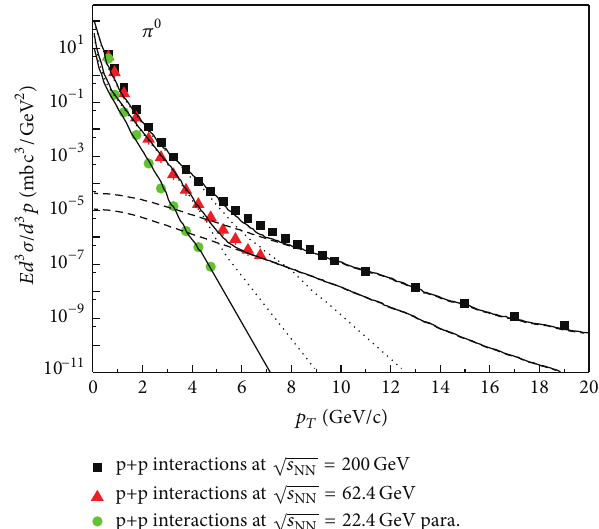
Figure 4: Invariant 𝜋 0 cross-section as a function of transverse momentum in p+p collisions at different RHIC energies. The error barsarethequadratic sumofstatistical and systematicuncertainties. Experimental data taken from the PHENIX Collaboration [35] are shown by the scattered symbols. Our results calculated from the cylinder model are shown by the